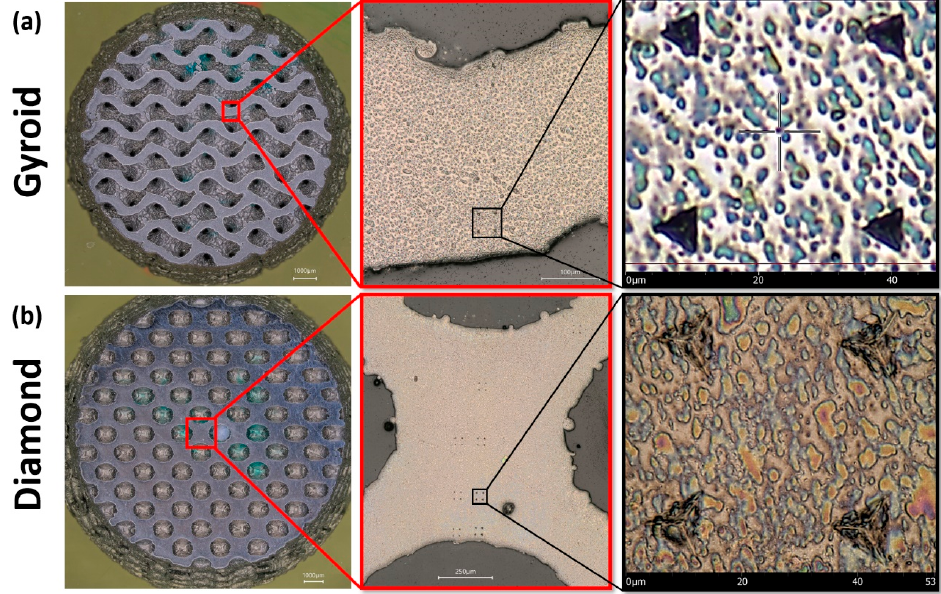
Figure 10. Optical image of indentations created under a load of 100 mN on ( a ) gyroid scaffold and ( b ) diamond scaffold.